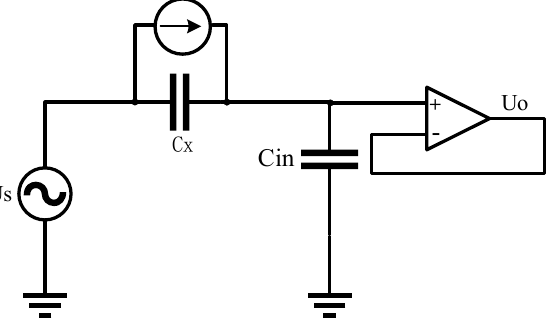
Figure 3. Simplified equivalent circuit diagram of the capacitive ECG measurements. Figure 2. Schematic diagram of the wearable electrode structure.